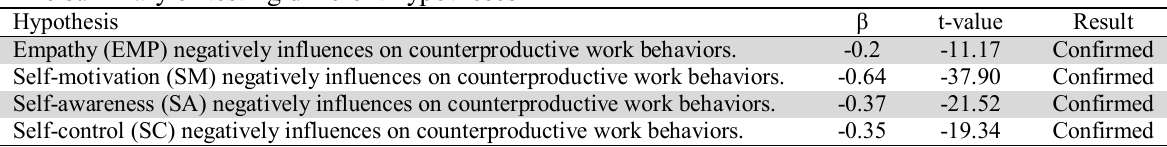
Hypothesis β t-value Result Empathy (EMP) negatively influences on counterproductive work behaviors. Confirmed Self-motivation (SM) negatively influences on counterproductive work behaviors. Self-awareness (SA) negatively influences on counterproductive work behaviors. Self-control (SC) negatively influences on counterproductive work